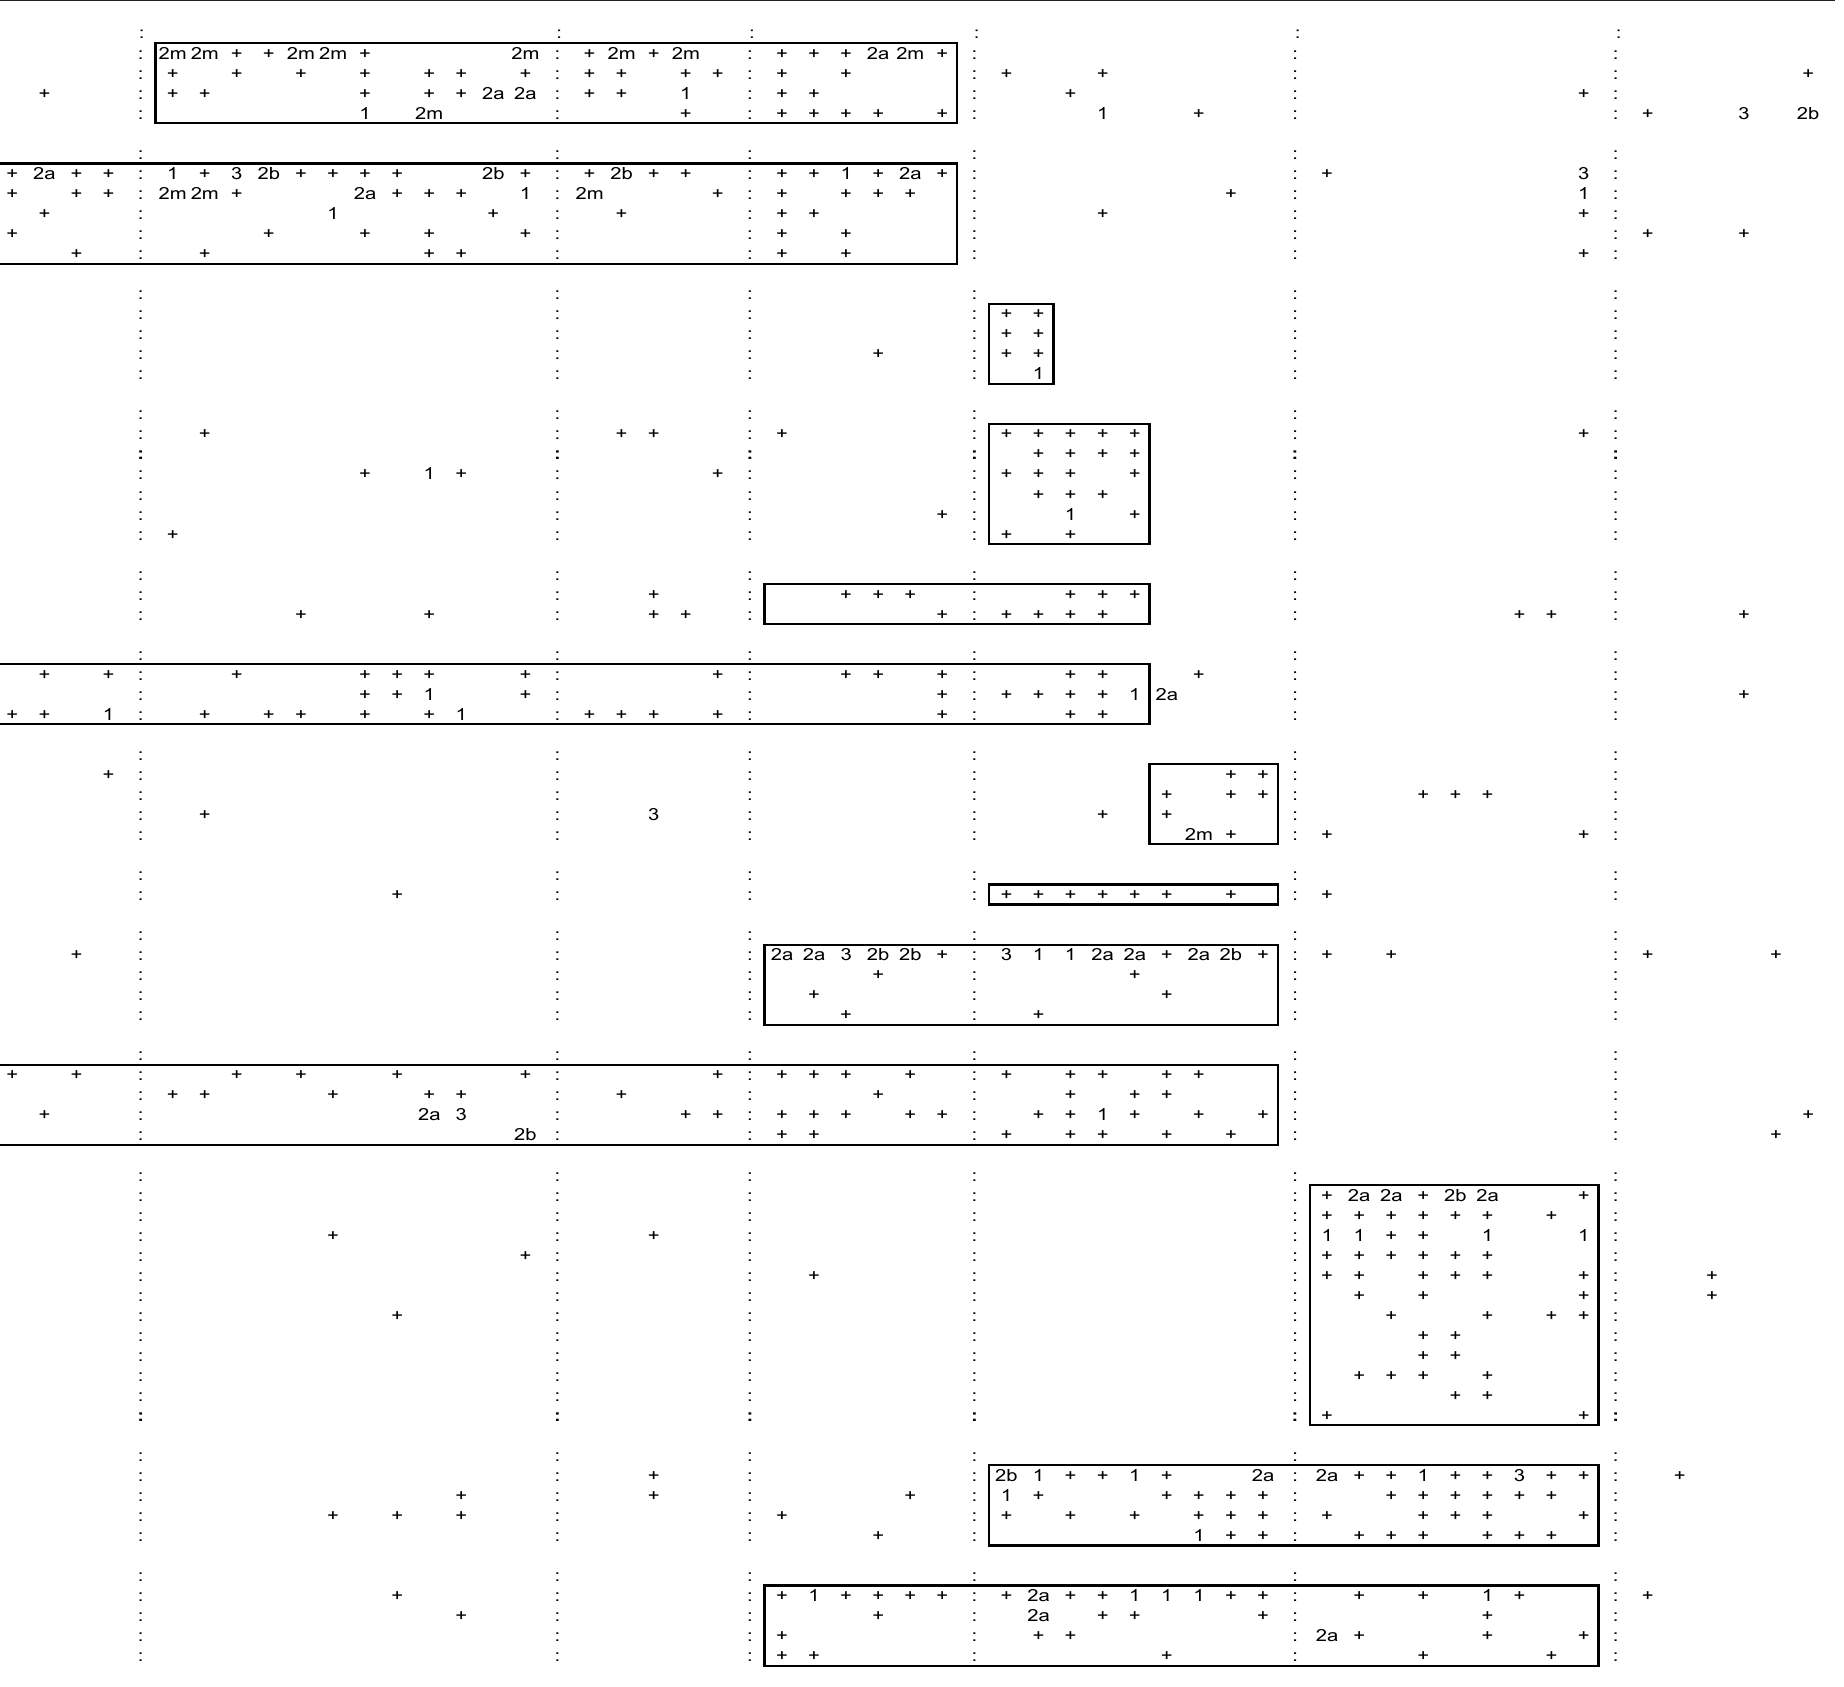
Phytosociologial table of the old field vegetation in the Namaqua National Park